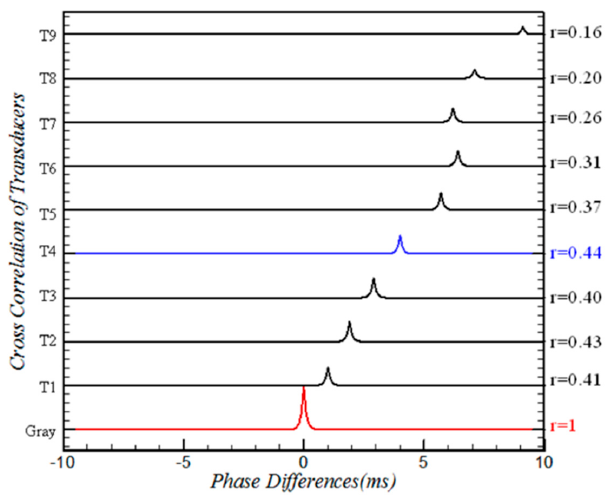
Figure 17. Phase analysis of T1–T9 and the grayscale ( t = 5 s).